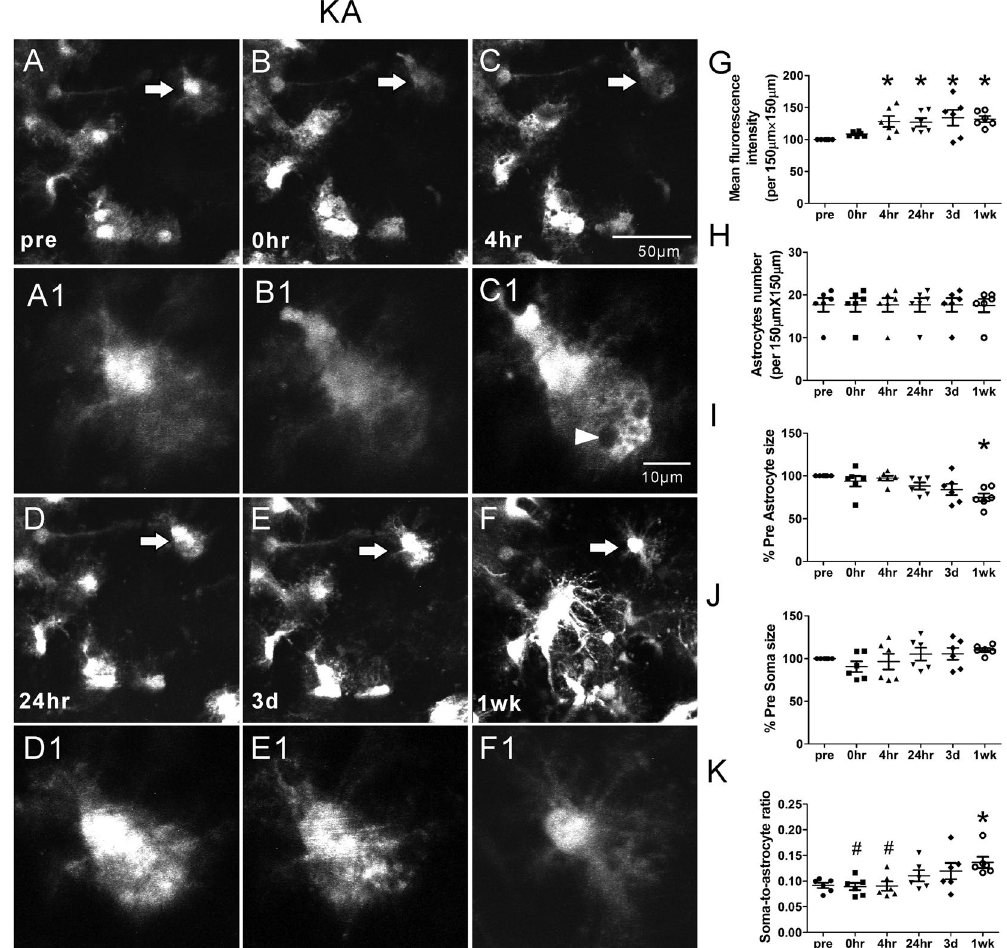
Figure 3. Representative in vivo images of astrocytes and quantitative analysis of astrocyte morphology features in the KA group. KA induced seizures caused acute astrocyte injury including vacuolization in most astrocytes followed by astrogliosis ( B-F , B1–F1). Vacuolization of astrocytes occurred immediately after seizures, peaked at 4 hr and persisted up to 3 days (arrow head in C1). One week after seizures, astrogliosis developed, characterized by a decrease in astrocyte size and loss of their classic bushy appearance, with fine individual processes becoming more prominent and extensive ( F , F1). No significant proliferation of new astrocytes was observed. However, mean fluorescence intensity increased at 4 hr, 24 hr, 3 d and 1 wk after seizures ( G ). Astrocyte size decreased significantly at 1 wk after seizures ( I ) and the soma-to-astrocyte ratio increased at 1 wk when compared to pre-seizure ( J ) (n = 6; * p < 0.05 compared with pre, by Kruskal-Wallis test with Dunns post- test). The arrows in the lower magnification images indicate the astrocytes displayed in the higher magnification